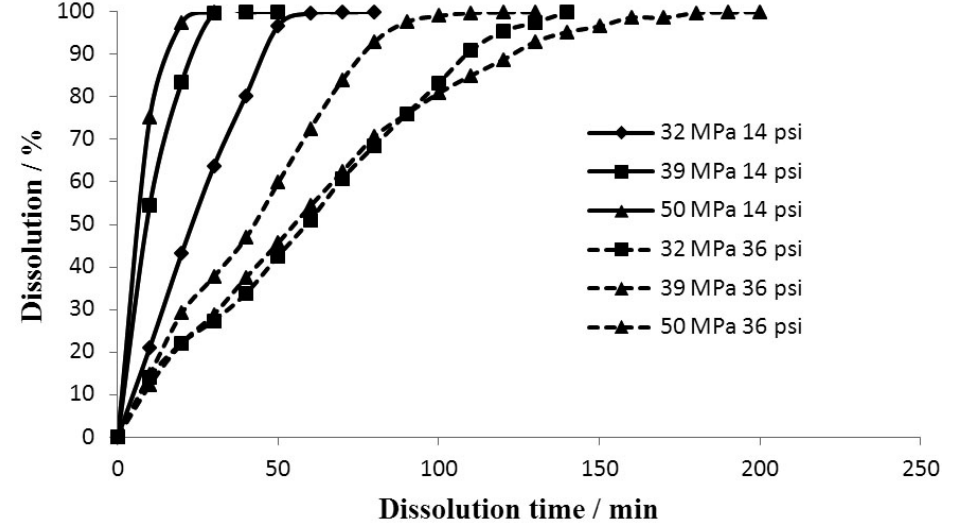
Figure 15. Dissolution behaviour for NaCl from infiltrated